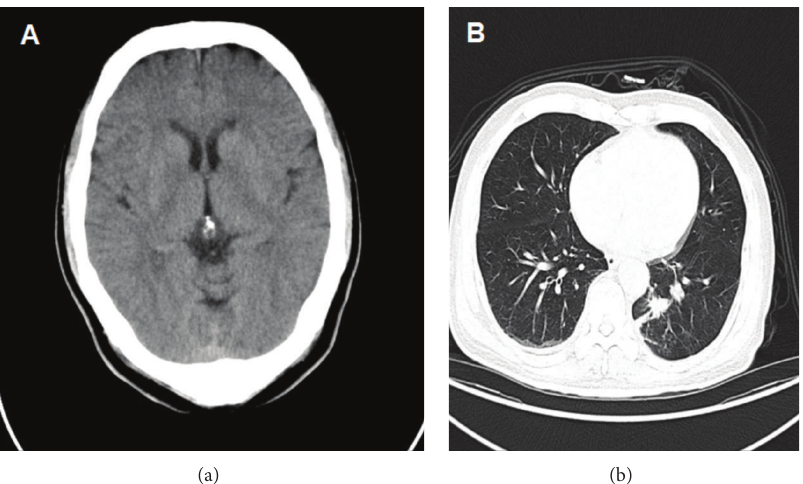
Figure 1: (a) Cranial CT produced no unusual findings. (b) Enhanced chest CT showed a mass with irregular border in the left to middle